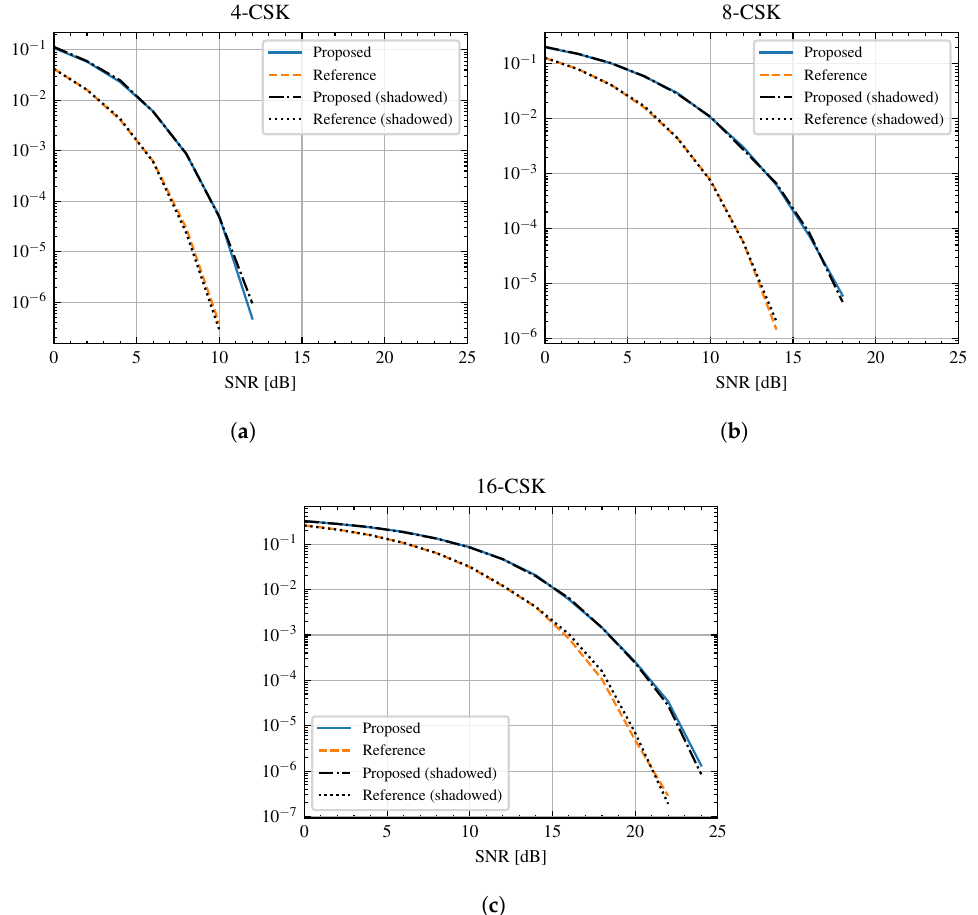
Figure 10. Bit error ratio curves for the proposed and reference models. Shadowed refers to RX position R 1 = ( 2,1,1.8 ) m, while non-shadowed refers to RX position R 2 = ( 4,1,1.8 ) m. ( a ) 4-CSK. ( b ) 8-CSK. ( c )